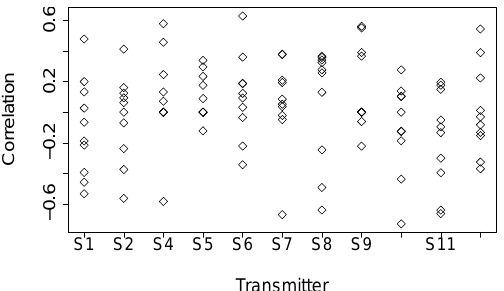
Figure 20. Correlation coefficient of any two links from each sending